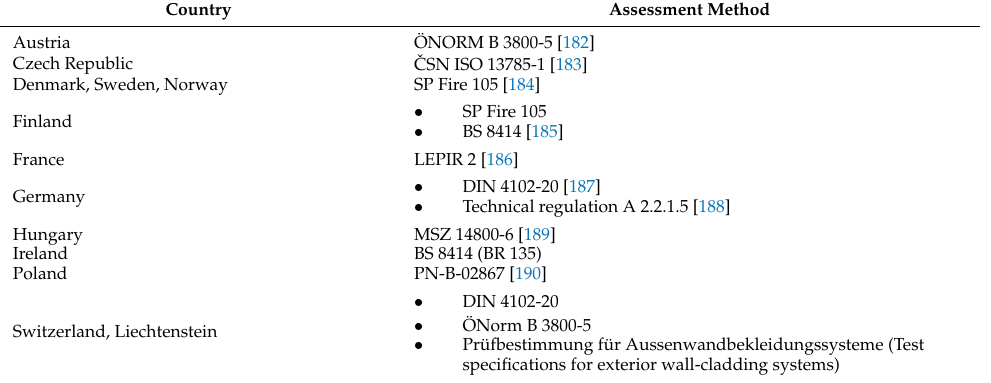
Table 5. Assessment methods applied by EU/EFTA Member States to assess the fire performance of